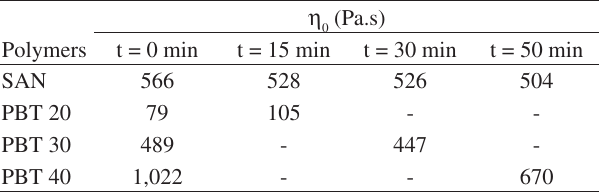
Table 3. The viscosity ratio, p, of the PBT and SAN samples, measured at 240 ° C for different